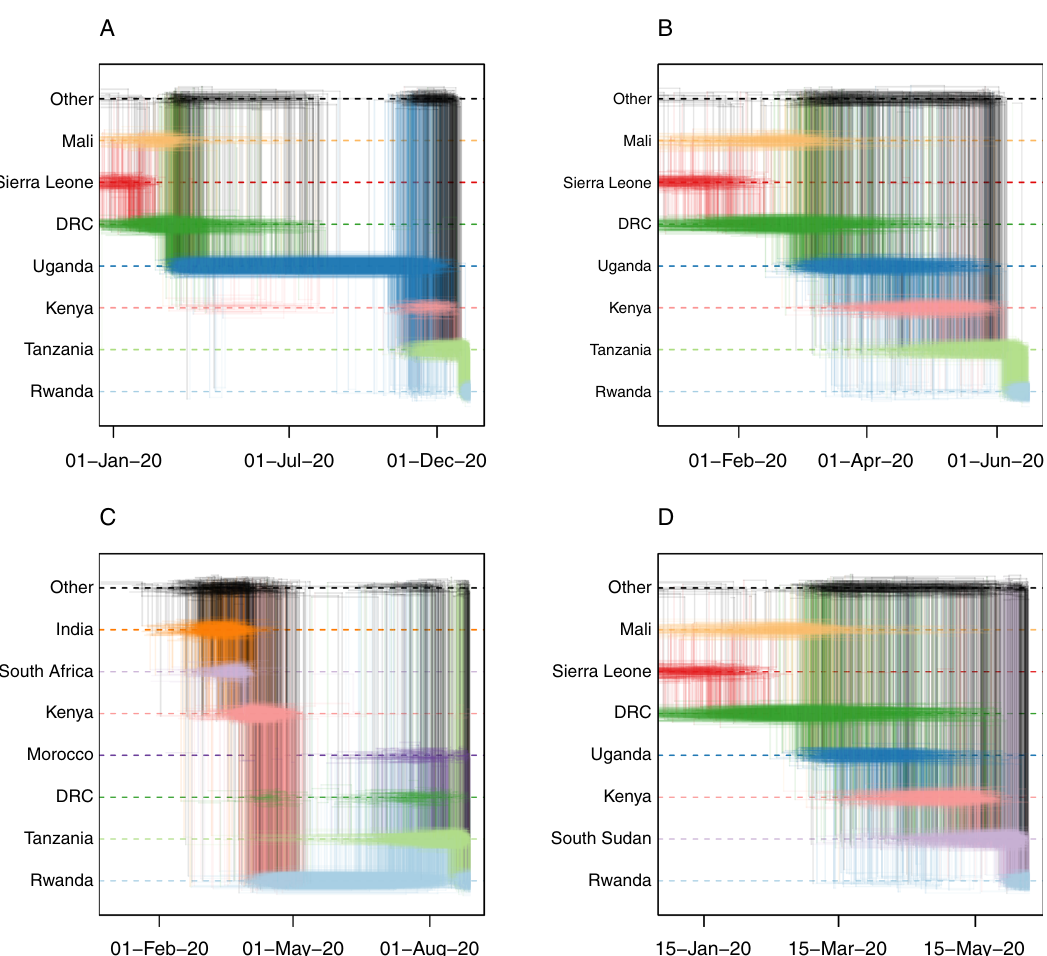
Fig. 8 Ancestral spatial trajectories for individual patients. Markov jump trajectory plots for four selected Rwandan infected individuals with travel history (returning) from Tanzania (A, B, C) and South Sudan (D). Each individual trajectory corresponds to the Markov jumps in a single tree from the posterior distribution, with each plot showing the uncertainty across a subsample of 1,000 posterior trees. The horizontal dimension represents the time maintained at an ancestral location. Vertical lines represent a Markov jump between two locations. The seven most prominent locations across all ancestral paths in the posterior are displayed along the Y-axis, with “ Other ” representing the remaining locations. Trajectory plots A , B , and D correspond to the isolates in subtree A, i.e. EPI_ISL_1064164, EPI_ISL_707772, and EPI_ISL_707712, respectively. Trajectory plot C corresponds to isolate EPI_ISL_960250 in subtree B.1. In all cases, considerable uncertainty in the ancestral reconstructions can be seen from the pattern of overlapping horizontal lines and the diffuse density of vertical lines, which indicate considerable support for different ancestral locations (i.e. uncertainty in the spatial reconstruction), and variance in the reconstructed timing of the introductions. For trajectory plots A , B , and D , we observe similar patterns in the spatial paths reconstructed, where the isolates fi nd ancestries in Mali/Sierra Leone/Democratic Republic of Congo, Uganda, and Kenya prior to each corresponding travel location. In contrast, trajectory plot C shows support for an ancestry in Rwanda prior to the virus circulating in Tanzania and being reintroduced into Rwanda. This indicates a bidirectional exchange of viral lineages between the two countries, although the possibility of an intermediary country being involved cannot be discarded due to unevenness in sampling efforts between